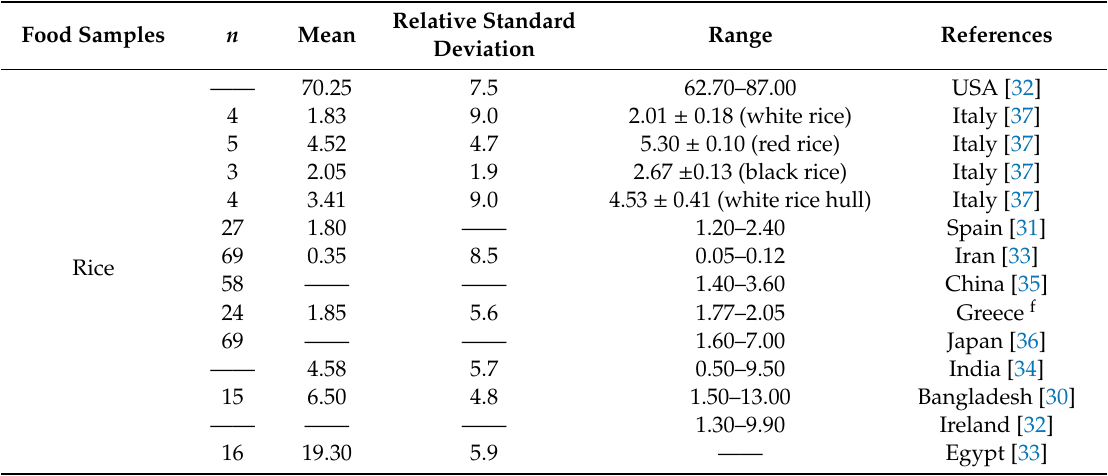
Table 2. Selenium concentration in rice samples reported by other authors ( µ g / 100 g, wet weight). Food Samples n Mean